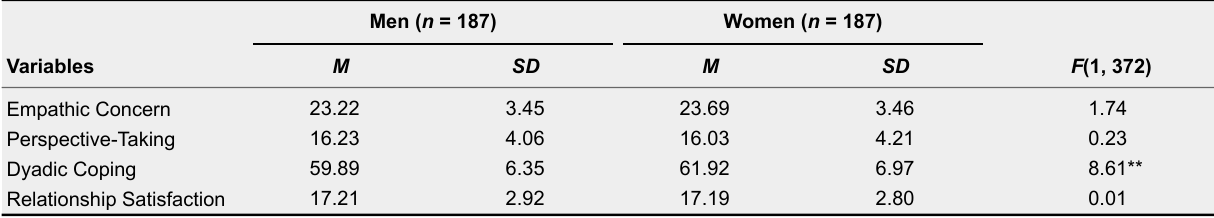
Means and Standard Deviations for Dyadic Empathy, Dyadic Coping, and Relationship Satisfaction